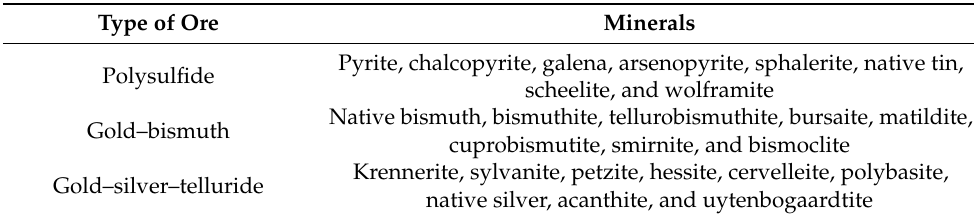
Table 1. Typification of the ores of the Spokoininsky cluster. Type of Ore Minerals Polysulfide